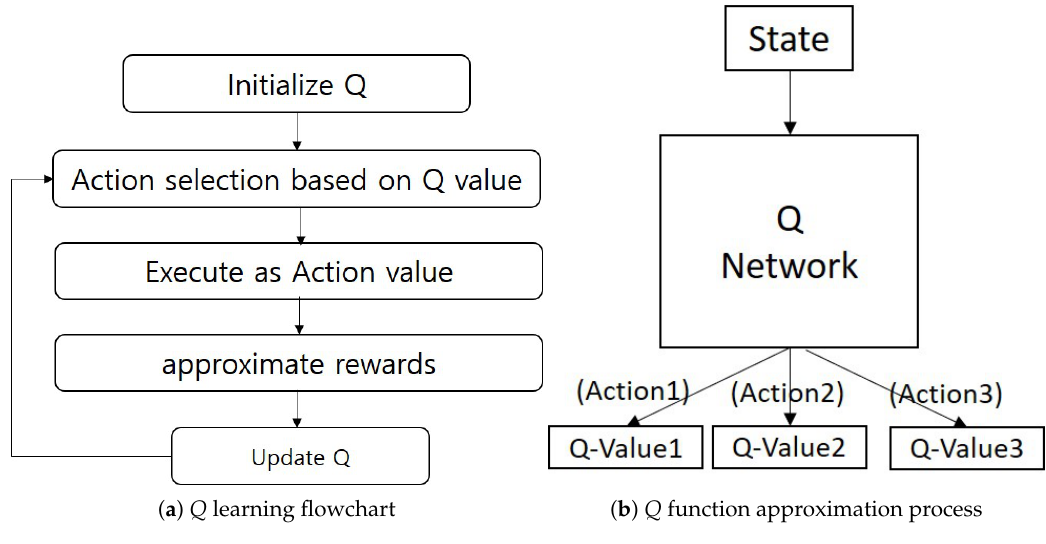
Figure 2. Q learning